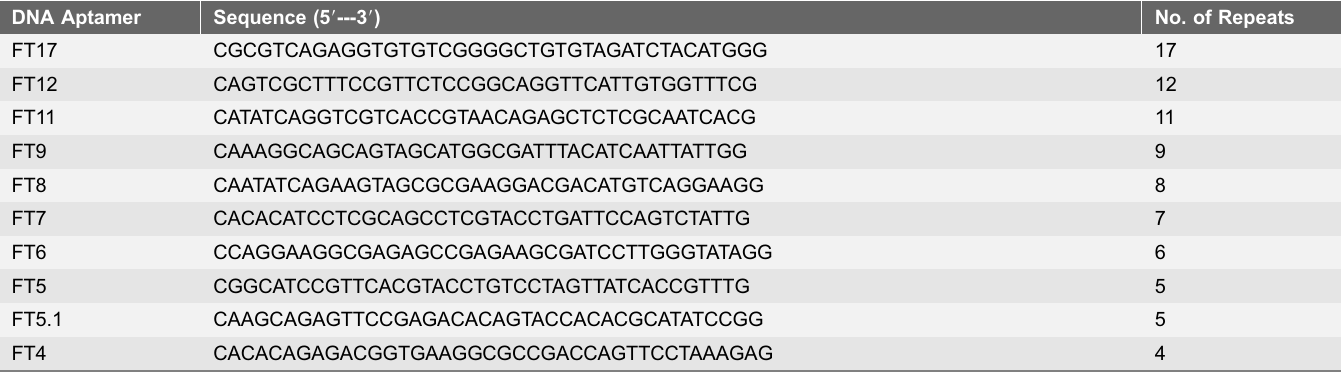
Table 1. Repeat DNA sequences and number of clones from sequenced aptamer pool a . DNA Aptamer